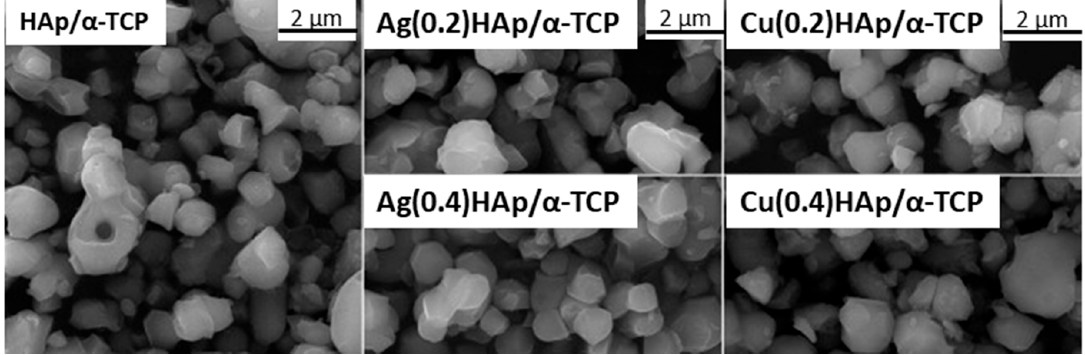
Figure 6. Field emission scanning electron microscopy (FESEM) micrographs of the powders calcified at 1200 °C (CuAg). Scale bar: 2 μ m. Reprinted from [104] with permission from Elsevier.